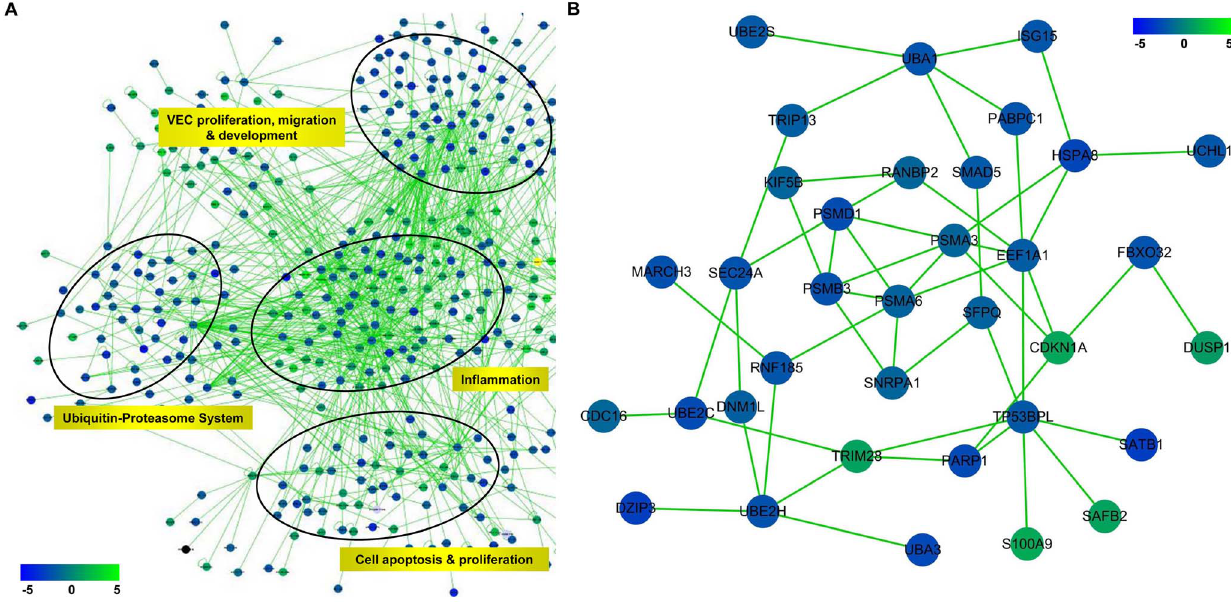
Figure 3. Interaction network based on integrated data at different levels in atherosclerosis. ( A ) The part of the constructed interaction network involved in atherosclerosis. It was shown that the functions of UPS, VEC proliferation/migration/development, Inflammation and cell apoptosis/proliferation were enriched significantly. The fold changes of expression of nodes (genes) were indicated by the color bar in the lower left corner. ( B ) The sub-network in which UPS was enriched was shown and the genes associated with UPS were mainly inhibited. The fold changes of expression of nodes (genes) were indicated by the color bar in the upper right corner.